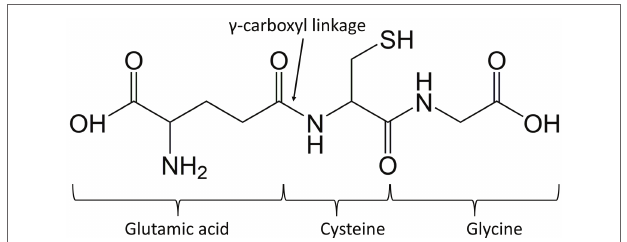
FIGURE 1 | Chemical structure of glutathione (GSH), a tripeptide made up of glutamic acid, cysteine, and glycine.